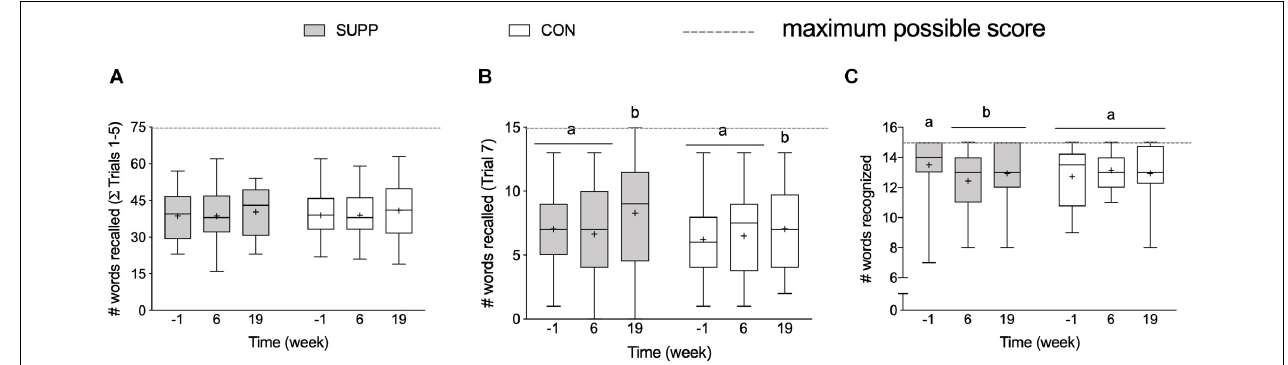
FIGURE 4 | Memory, assessed with the RAVLT. (A) Sum of words recalled during Trials 1–5 (out of a possible 75-word total). (B) Number of words recalled following a 30 min delay (Trial 7; out of a possible 15-word total). (C) Number of words recognized in the 30-word visual recognition list (out of a possible 15-word total). Boxes (SUPP: gray; CON: white) represent interquartile (25th to 75th percentile) ranges, with the horizontal lines indicating the median. Whiskers represent the maximal and minimal values, and the cross indicates the mean. Dissimilar letters denote changes over time within a given treatment group (SUPP or CON). RAVLT, Rey Auditory Verbal Learning Test; SUPP, supplement; CON, control.